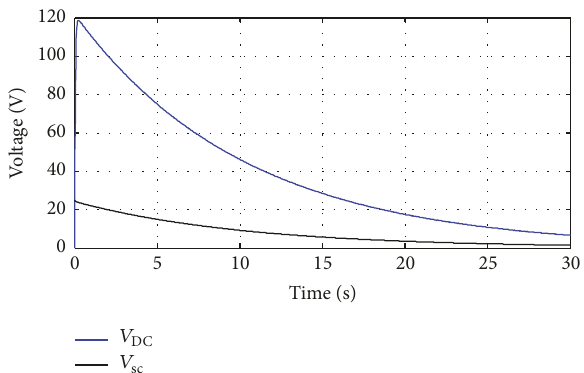
Figure 10: Output and the ultracapacitor voltage.